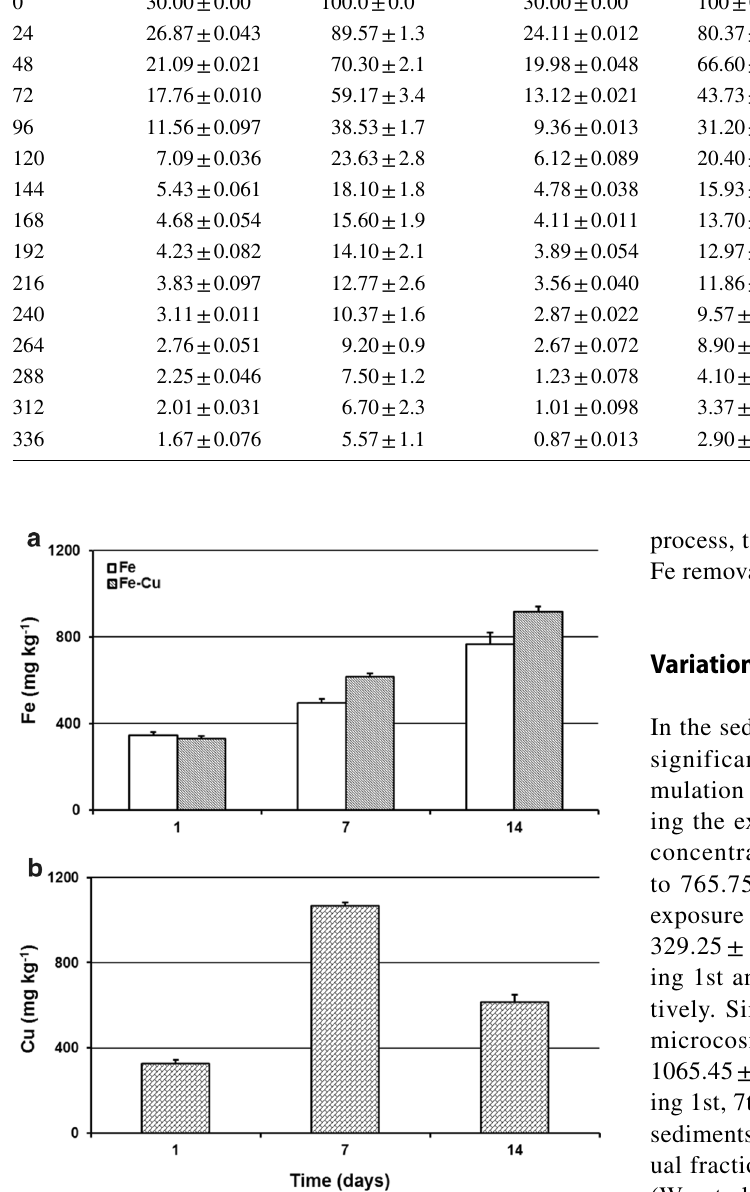
Fig. 2 Accumulation of ( a ) iron and ( b ) copper in the sediment of the two microcosms (Fe and Fe-Cu). Error bars represent SD ( n =